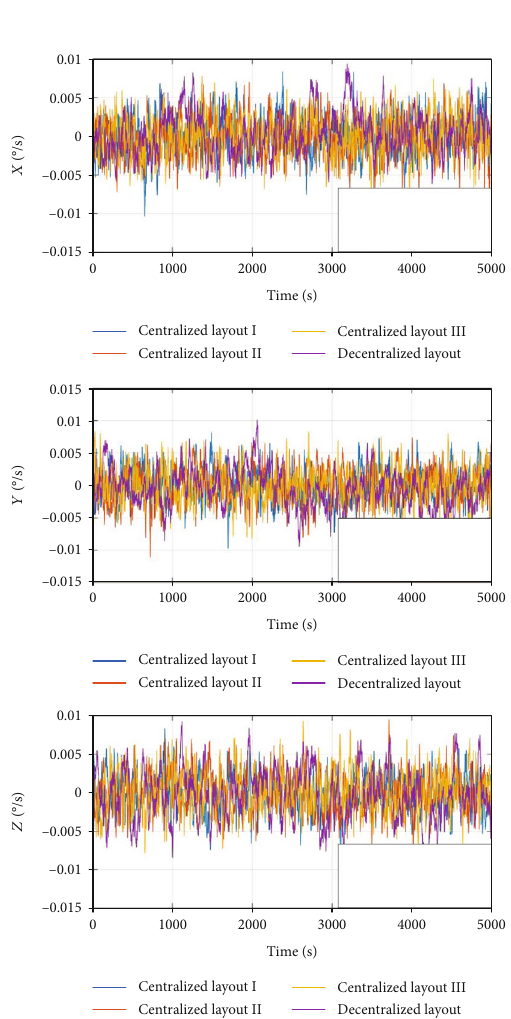
Figure 10: Estimation error of gyro biases (stable